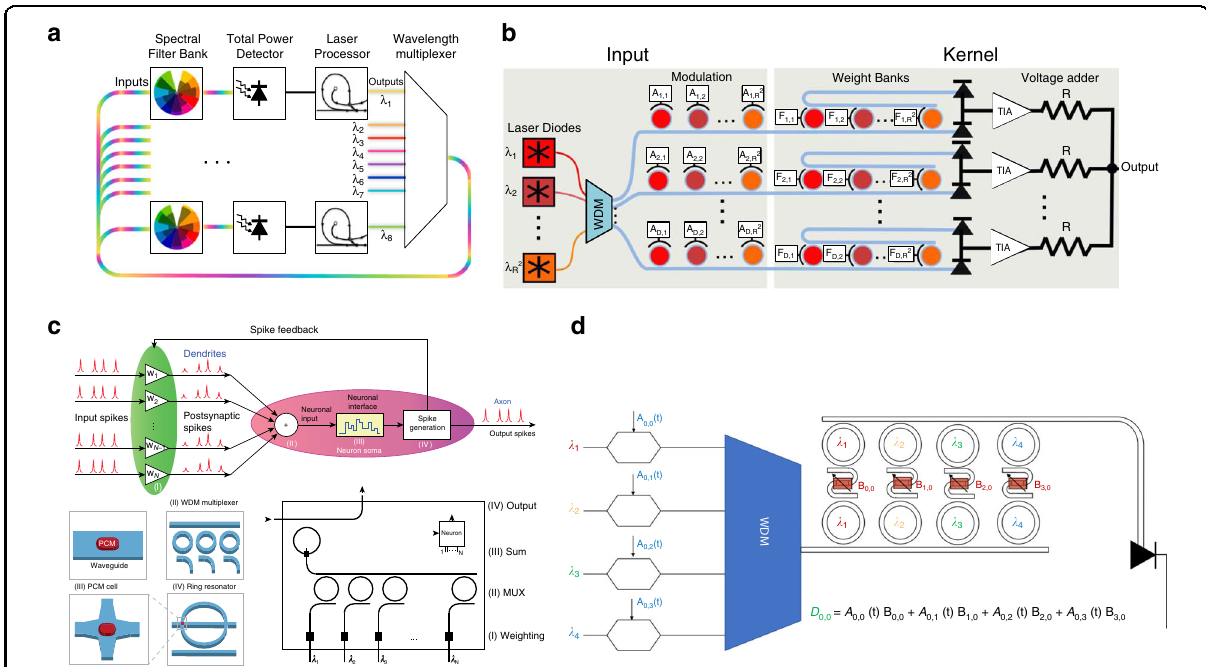
Fig. 12 WDM-MVMs for ONNs. a Optical broadcast-and-weight network showing parallels with the neural network mode 82,84 . b Optical convolutional neural network 92 . c All-optical spiking neurosynaptic networks 89 . d Photonic dot product engine for machine learning 129 . a Reprinted from ref. 82 with the permission of IEEE Publishing. b Reprinted from ref. 92 with the permission of IEEE Publishing. c Reprinted from ref. 89 with permission from Springer Nature: Nature. d Reproduced from ref. 129 with the permission of AIP